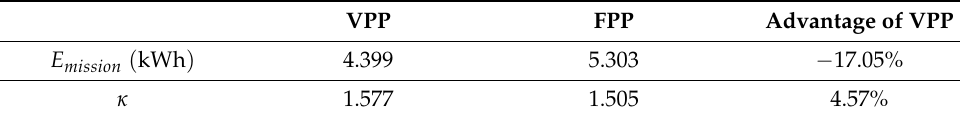
Table 4. Comparison between VPP and Figure 24. Average relative blade width and average twist amplitude of different optimal FPPs. Table 4. Comparison between VPP and FPP.